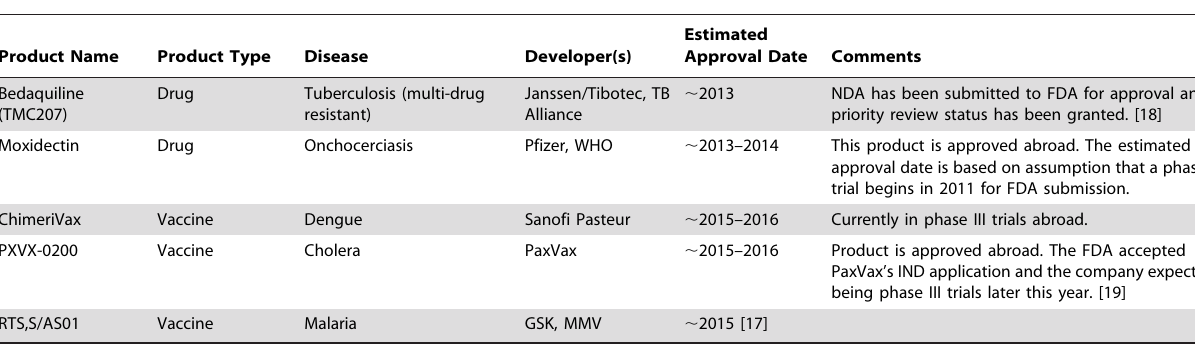
Table 3. NTD products expected to seek FDA approval in the next 5 years.